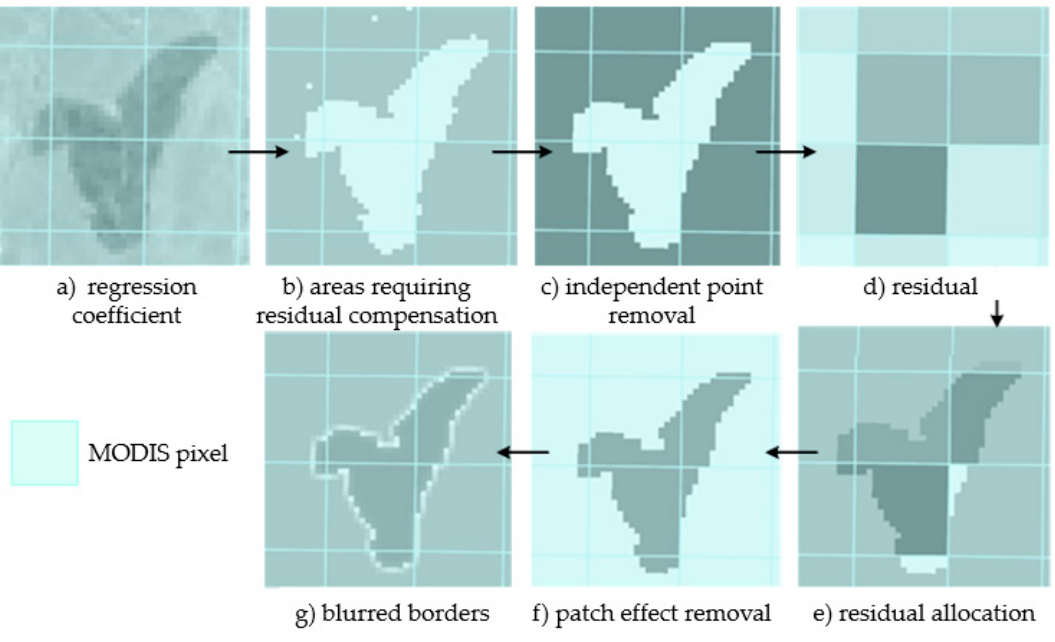
Figure 4. Residual distribution process.